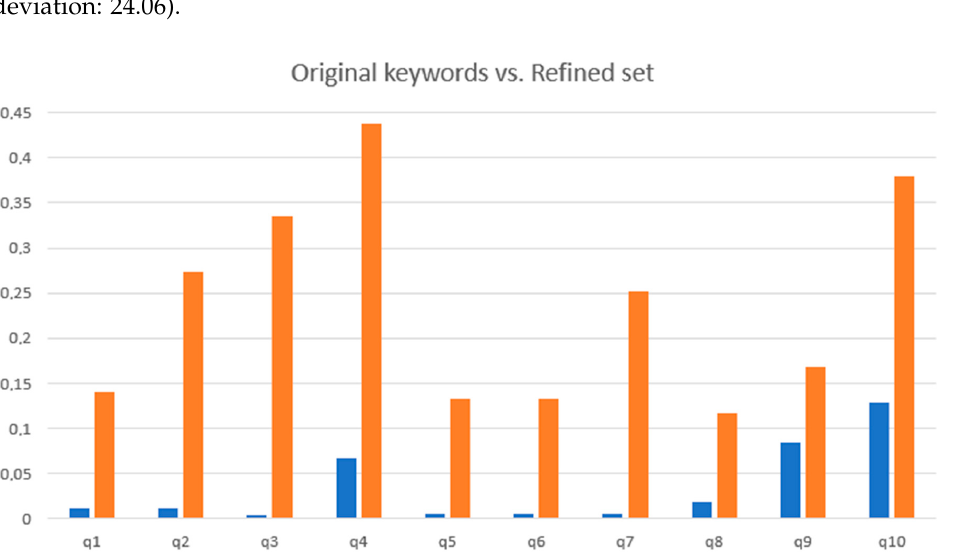
Figure 12. This figure compares the AS score obtained using the original set of keywords (blue bars) with the AS score obtained using the refined keywords (red bars).